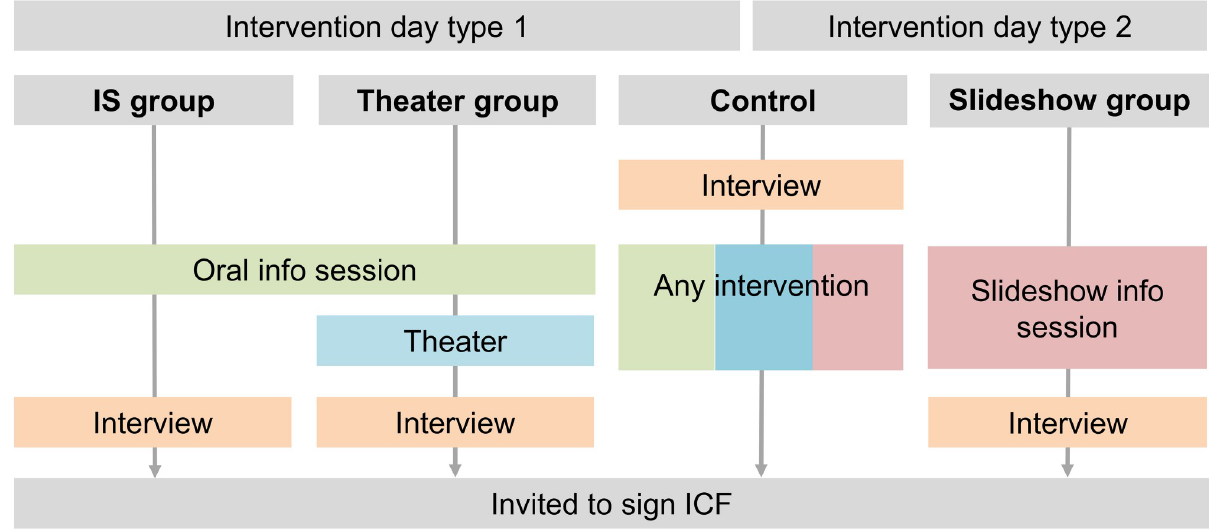
Fig 1. Flow chart describing the procedures during the two types of intervention days. ICF = informed consent form, IS = information session.